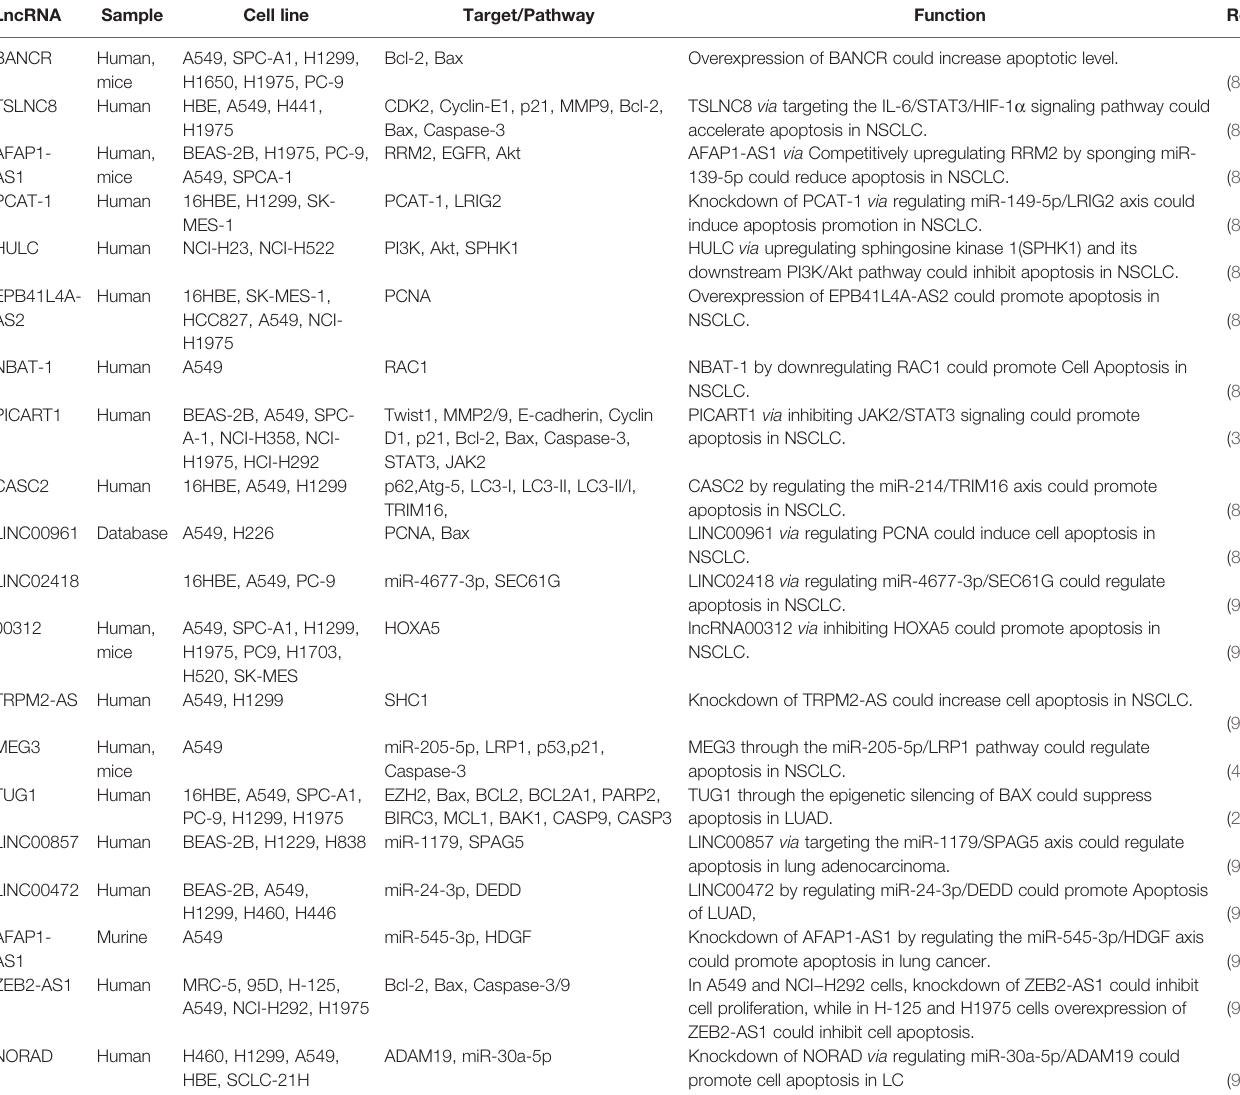
TABLE 3 | Prognostic role of apoptosis-related lncRNAs in lung cancer. Sample Ref